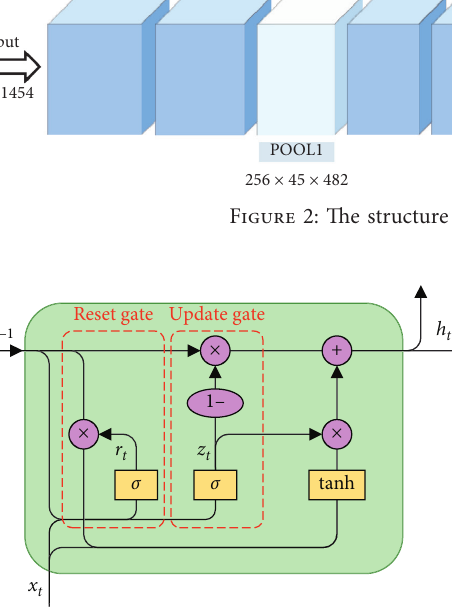
Figure 3: The detailed structure of the gated recurrent unit. z r t are update gate and reset gate,